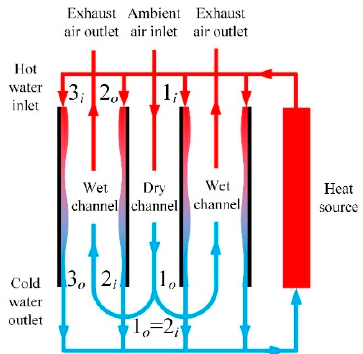
Figure 1. Schematic of the M-Cycle cooling tower.